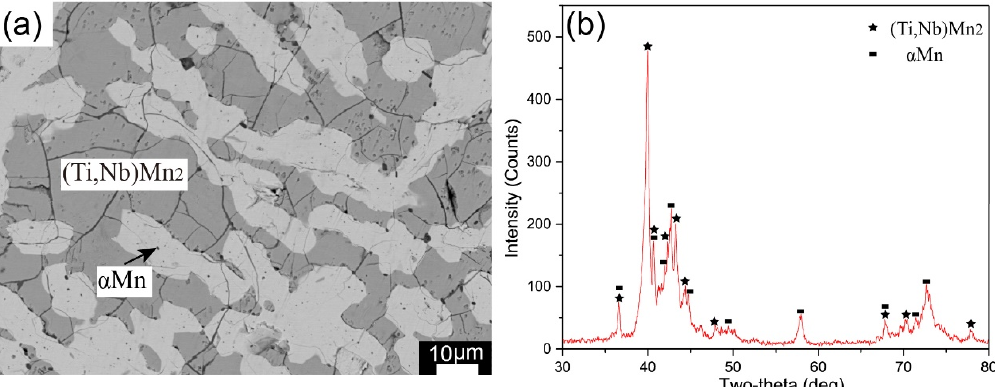
Figure 13. Alloy A17 annealed at 1173K for 90 days: ( a ) back-scattered electron (BSE) images , ( b ) XRD patterns.